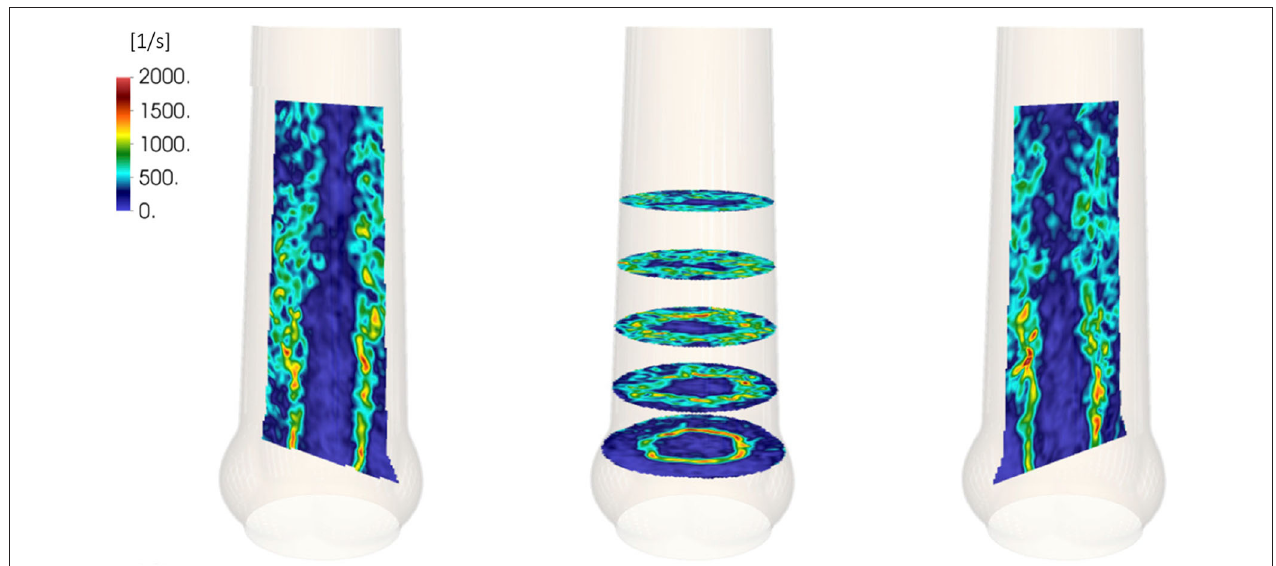
FIGURE 1 | Shear rates in the systolic flow behind a BHV. Adapted from experimental results by Hasler and Obrist (2018).